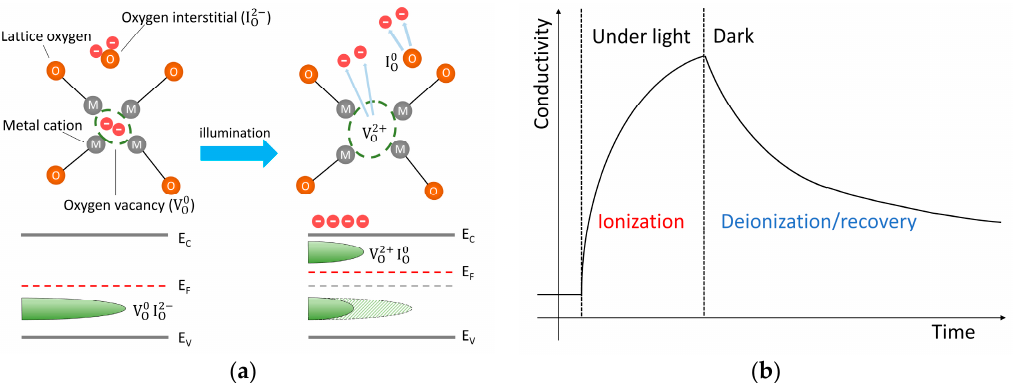
Figure 3. ( a ) Reaction diagram about ionizations of oxygen defects under illumination. Here, the lattice of the oxygen vacancy is depicted to be relaxed during the optically-induced ionization, thus an increase of the activation energy (redrawn and adapted from [21]). ( b ) Conductivity as a function of time. A seen, under illumination, conductivity of the transparent conducting oxide (TCO) film increases due to emitted free electrons during ionization process of the oxygen defects, and that under dark slowly decreases due to slow recombination of the free electrons.